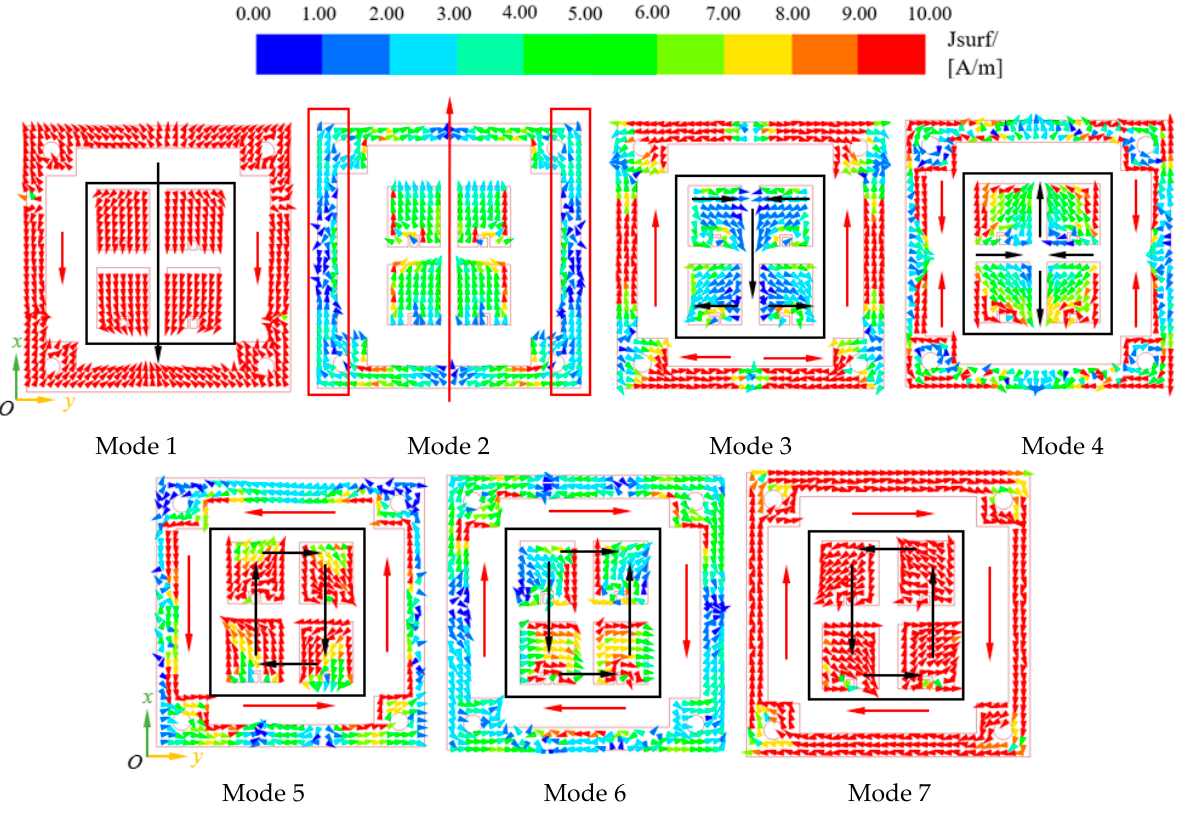
Figure 6. The current mode distribution of the coplanar radiator.